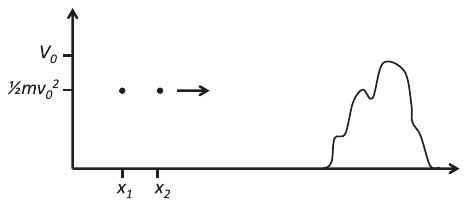
FIG. 1. Two one-dimensional worlds, with equal masses m and initial speeds v 0 , approach a potential energy barrier of height V 0 . Because of mutual repulsion the leading world can gain sufficient kinetic energy to pass the